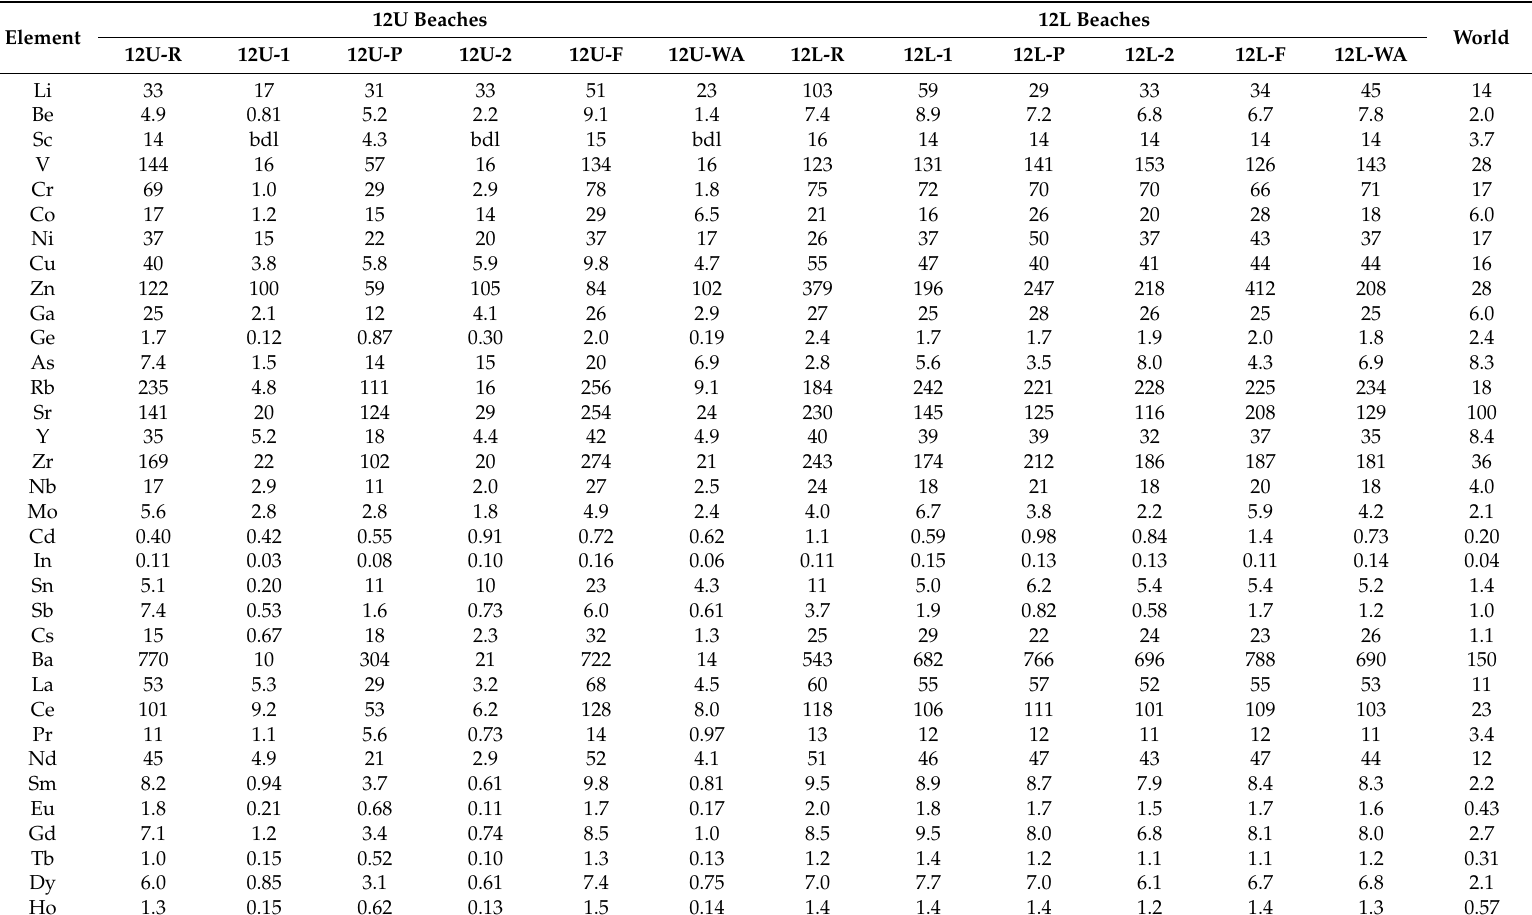
Table 3. Concentrations of trace elements in coals and host rocks from the Meitian Mine ( µ g/g).